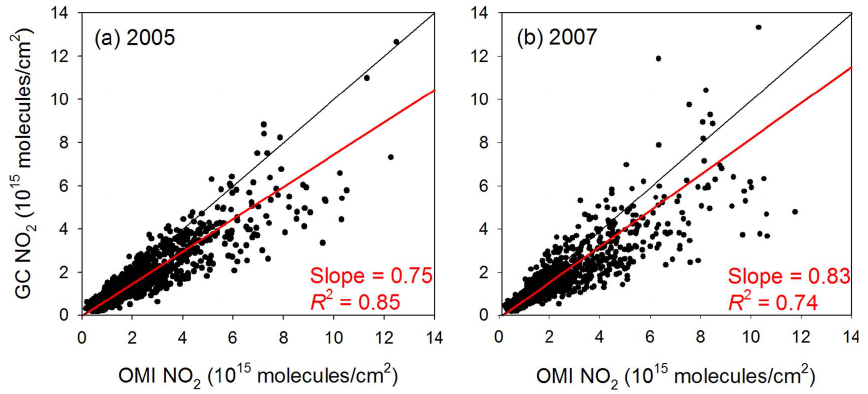
Fig. 5. Comparisons between GEOS-Chem and OMI summer average tropospheric NO 2 columns for (a) 2005 and (b) 2007 over all grids in China. RMA algorithm is used in the linear fitting (red